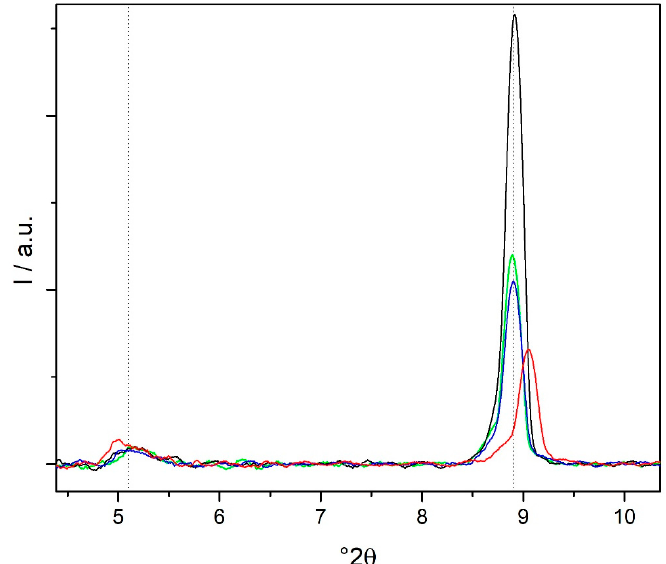
Figure 10. Superimposition of the smoothed XRD patterns in the low angle region for K10-Mt (black line) K10-Mt/CV (red line), K10-Mt/Pb (II) (green line) and K10-Mt/Ce(III) (blue line).